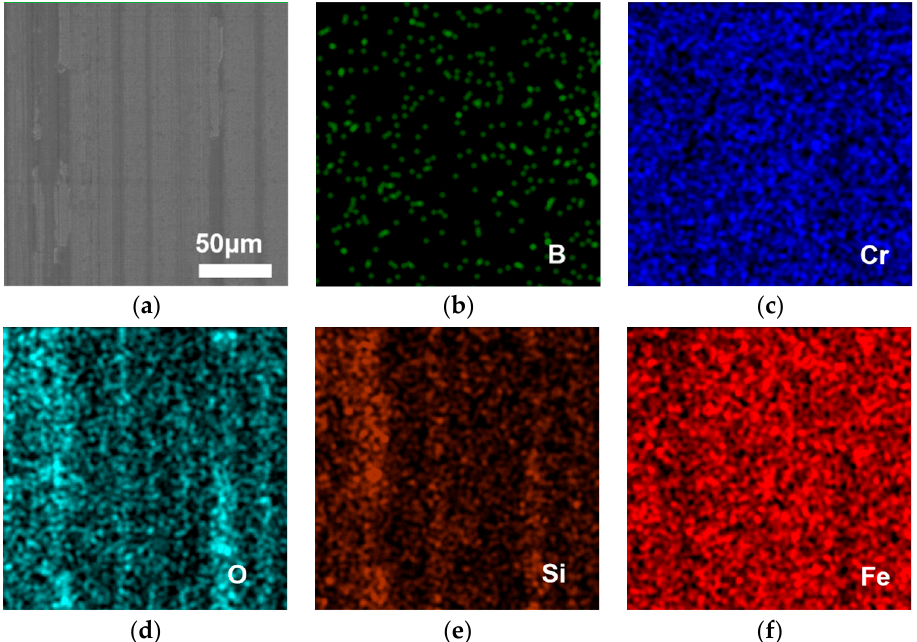
Figure 7. Fe-based coating EDS images. ( a ) The image of Fe-based coating SEM; ( b ) The content of the B element is 4.13%; ( c ) The content of the Cr element is 10.14%; ( d ) The content of the O element is 22.26%; ( e ) The content of the Si element is 3.52%; ( f ) The content of the Fe element is 48.98%.